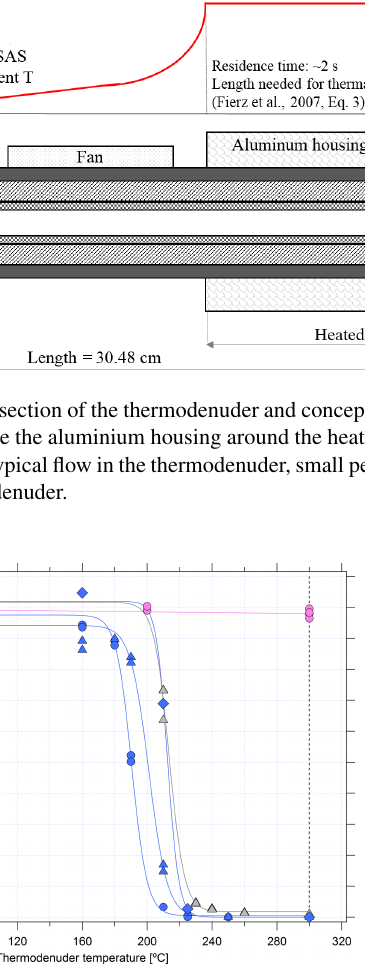
Figure 7. Particle response to heating as a function of temperature of the thermodenuder, particle size, and composition. Data normal- ized to the number measured at ambient temperature. Solid lines are used to guide the eye. The stability of the set temperature (dashed line) was within ± 0.5 ◦